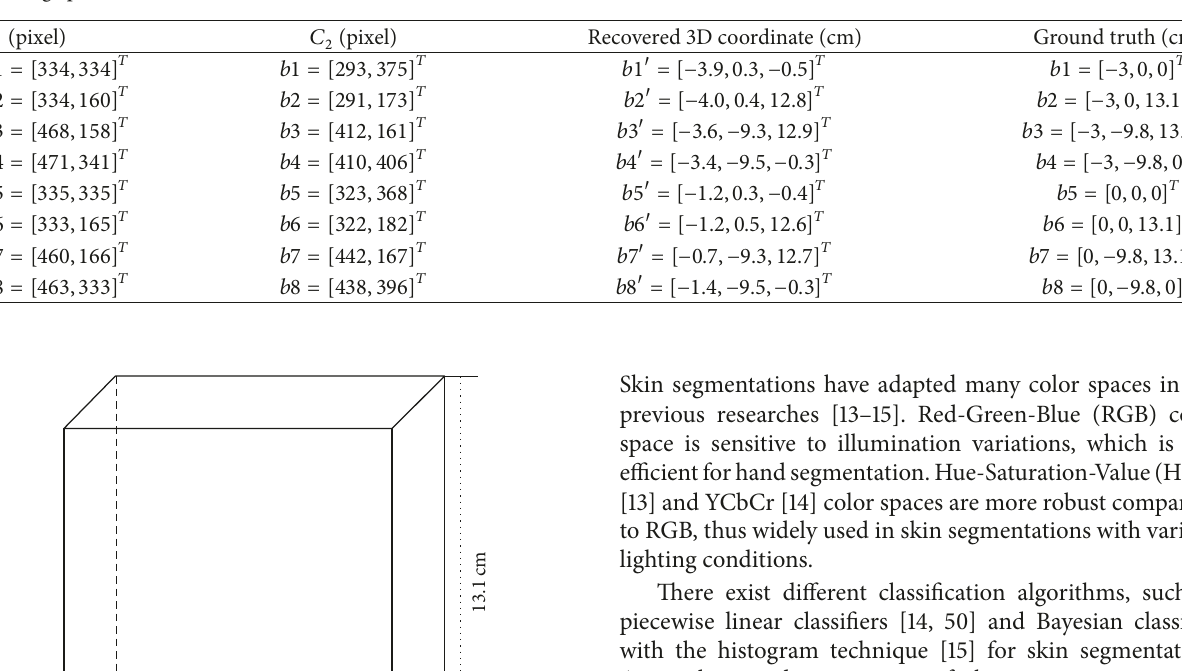
Table 1: The 3D coordinates of eight corner points on the plastic box in the world coordinate system recovered by their projected points on the image plane of two cameras.